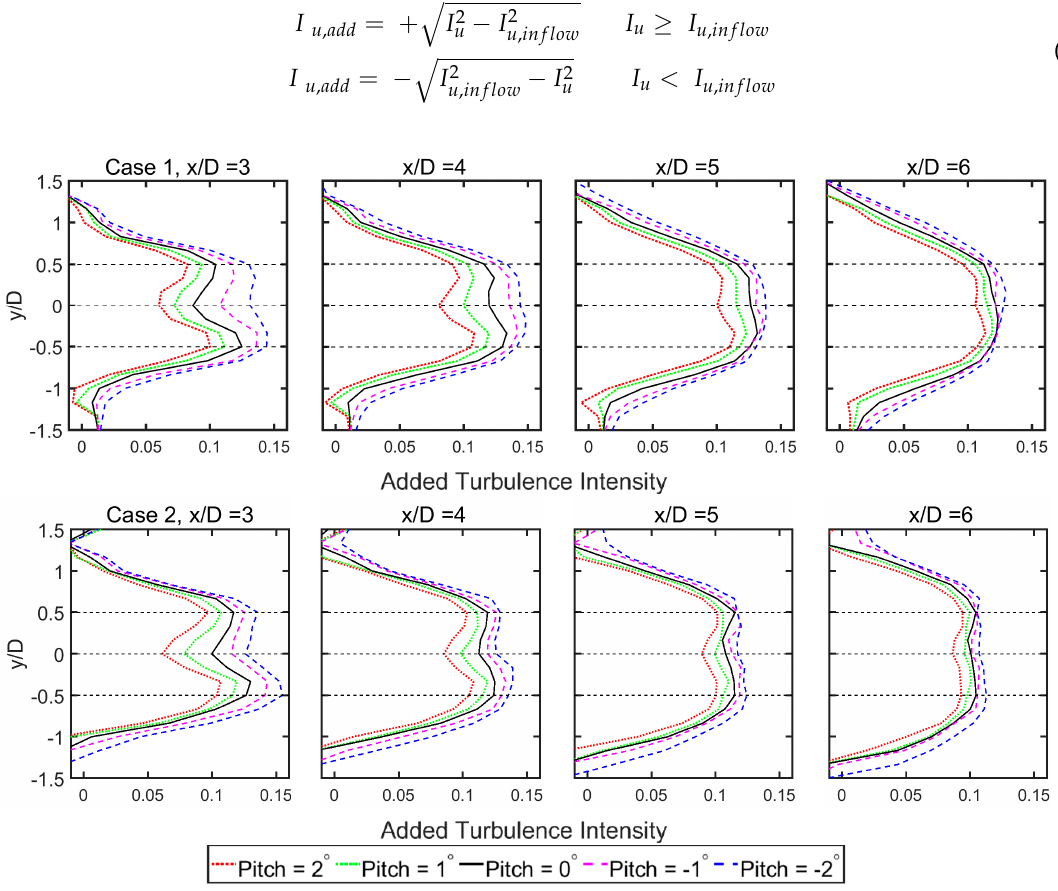
Figure 5. Spanwise profiles of turbine added turbulence intensity at the hub height for a turbulence intensity of 4.3% ( top ) and 6.3% ( bottom ) for the incoming flow.